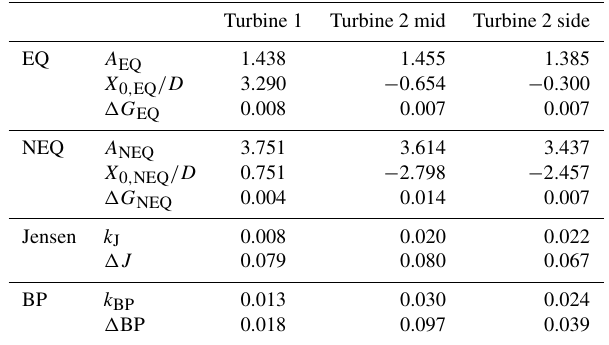
Table 2. Fit parameters and RMS errors for the different models predicting the evolution of (cid:49)U/U ∞ for the three scenarios at the